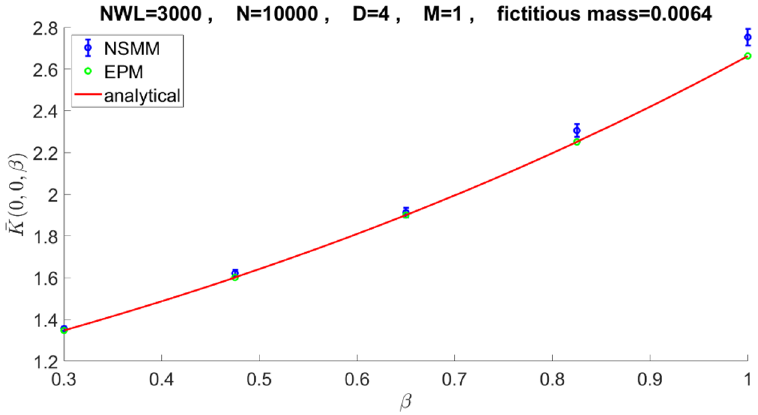
Figure 3 . High precision calculation of the heat kernel for the free scalar particle on the sphere with ( N WL , N ) = (3000 , 10000) .